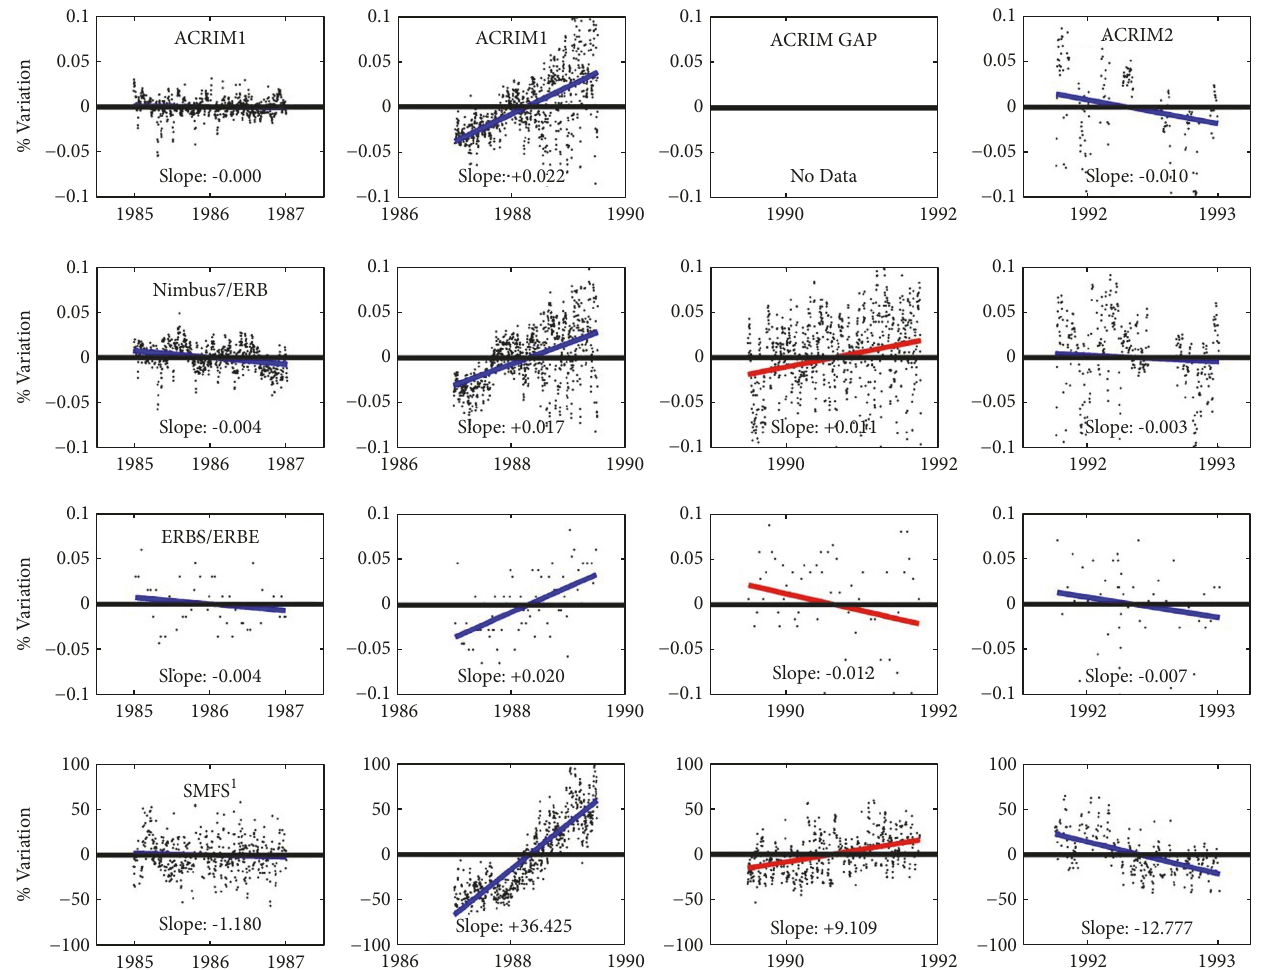
Figure 2: Comparison of the TSI results from the ACRIM1, Nimbus7/ERB, ERBS/ERBE experiments and the NSO/Kitt Peak Solar Magnetic Field Strength (SMFS) during the solar cycle 21-22 minimum and the upward trend to and through solar cycle 22 maximum. The effect of degradation for the ERBE sensors during the 1989–1992 maximum is seen in the downward trend of its results relative to the trends of the ERB results and the SMFS that is anticorrelated with the SMFS–TSI